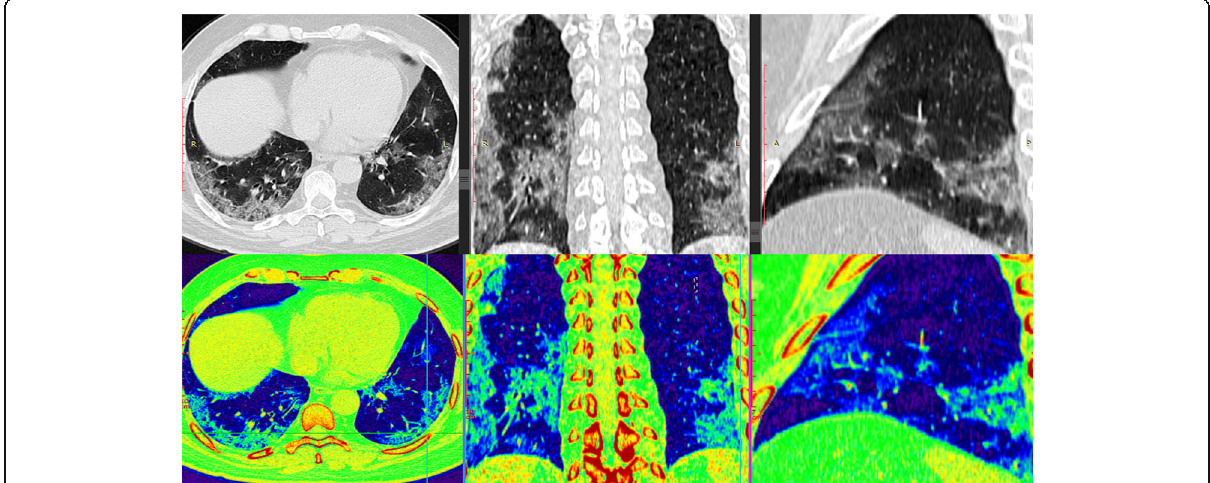
Fig. 5 A 51-year-old male patient presented with fever, cough, and dyspnea. MSCT scan with multi-planar and color-coded images revealed widespread bilateral predominantly peripheral subpleural patchy and confluent ground glass opacities with septal and vascular thickening and reverse halo “ atoll sign “ . CT-SSS was 15 and serum LDH was 632. The patient exhibited severe disease course with ICU admission for 12 days followed by clinical improvement and discharge